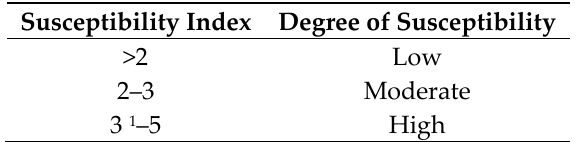
Table 2. Index values and the degree of susceptibility to landslides.